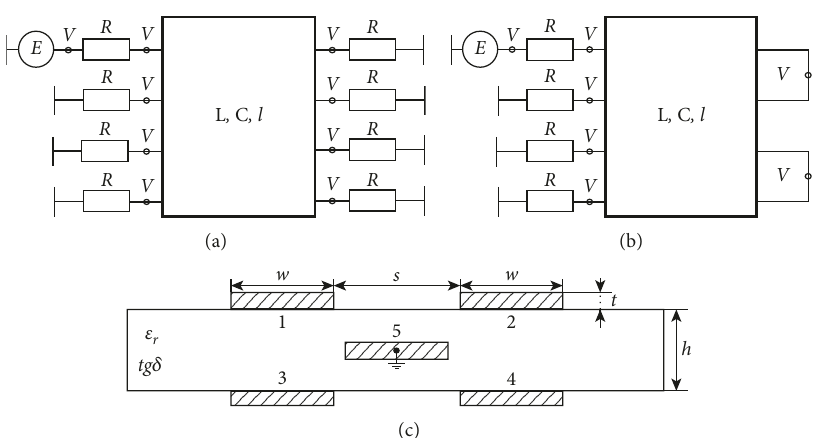
Figure 9: Equivalent circuits of reflection symmetric (a) MF, (b) ML, and their (c) cross-section.